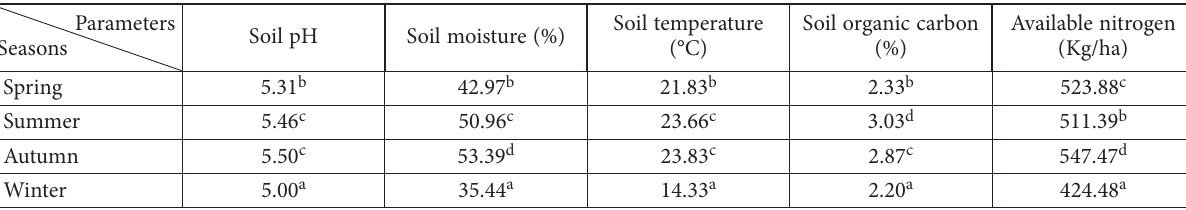
Table 5. Effect of season on soil parameters at FRS